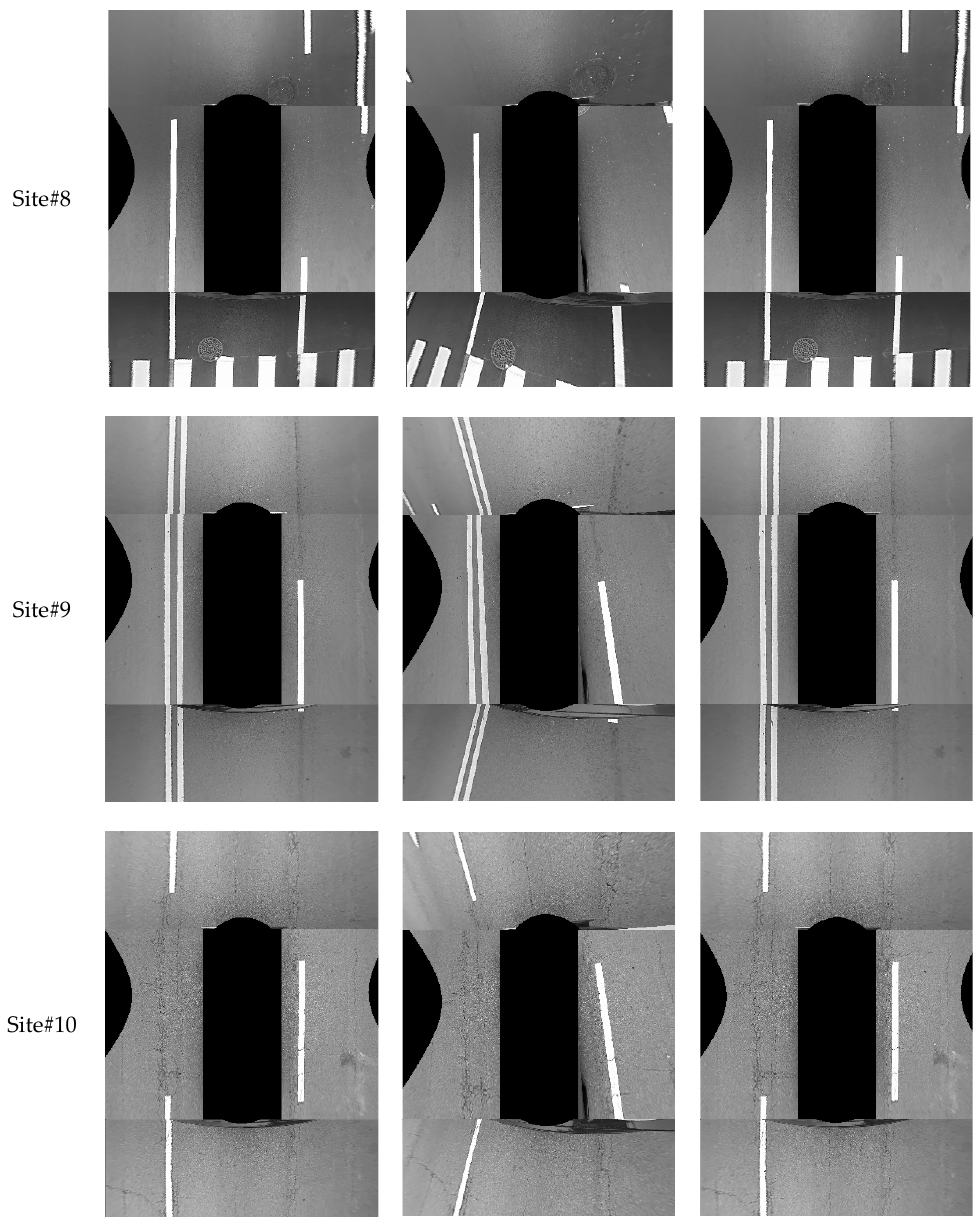
Figure 14. Resulting AVM images at 10 different sites. ( left ) AVM images generated by the ground truth camera angles; ( middle ) AVM images generated by the initial camera angles; ( right ) AVM images generated by the camera angles resulting from the proposed method.